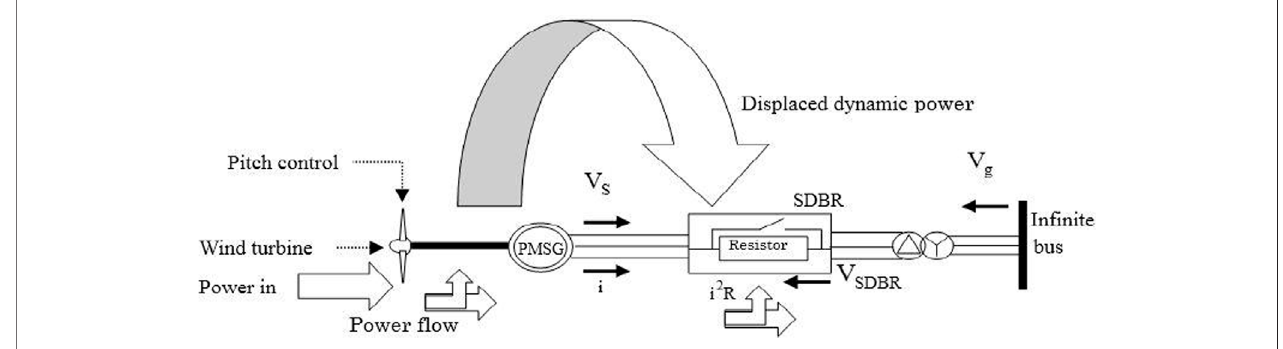
FIGURE 3 | Dynamics of SDBR at the stator side of the PMSG wind